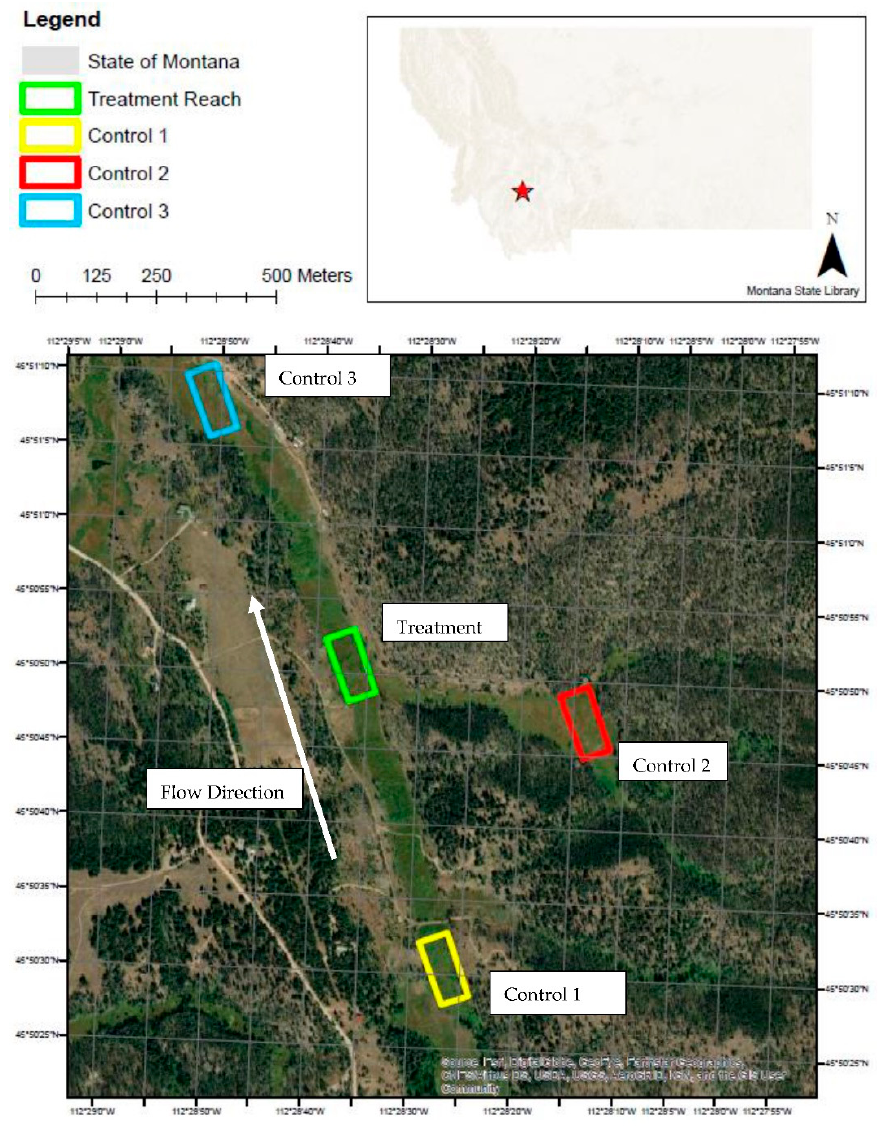
Figure 1. Study Reach Locations.